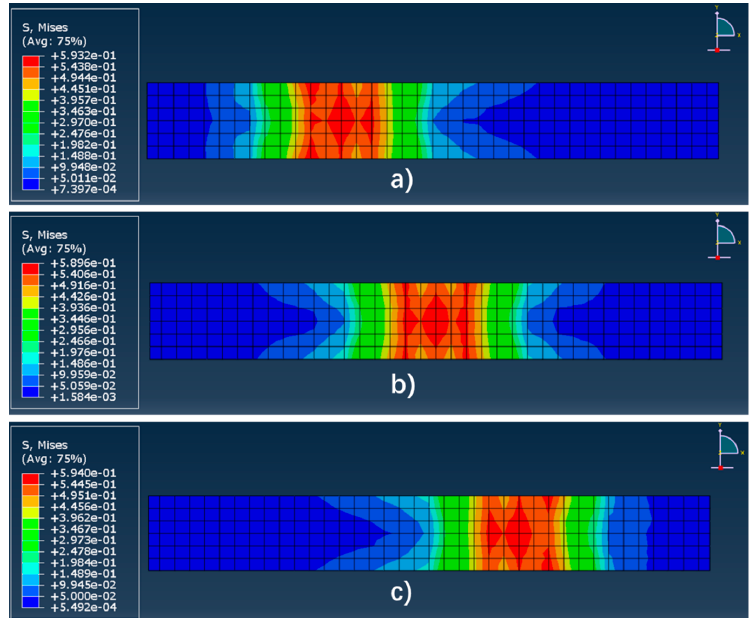
Figure 22. The stress distribution of the system surface under different loading position. ( a ) Load on the zone in the middle of 1# and 2# (Left); ( b ) load on the zone in the middle of 2# and 3# (Middle); ( c ) load on the zone in the middle of 3# and 4# (Right).